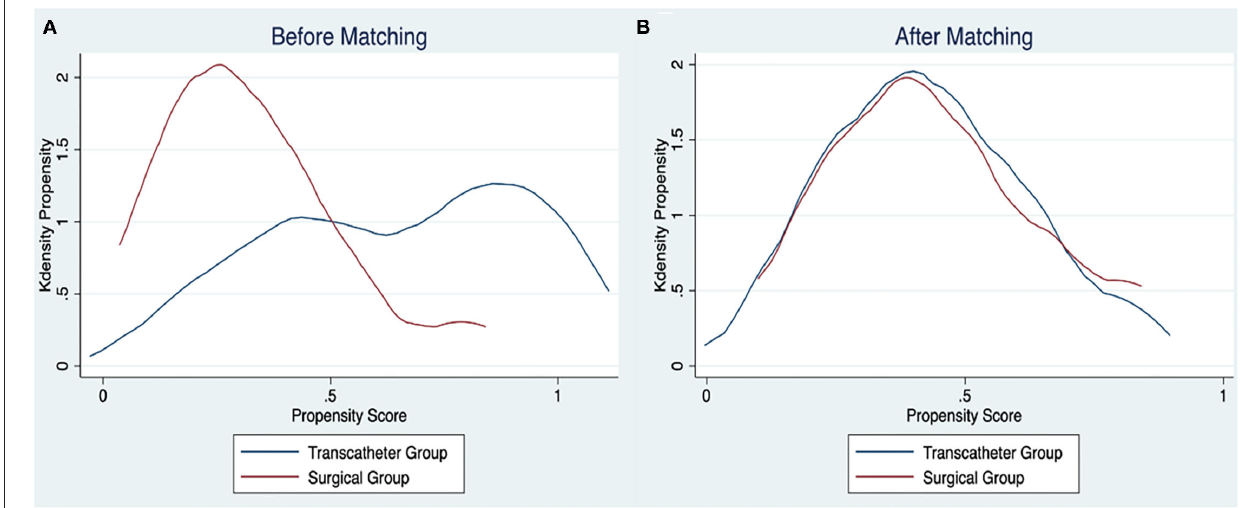
FIGURE 1 | Propensity score distribution. (A) Before matching; (B) after matching.